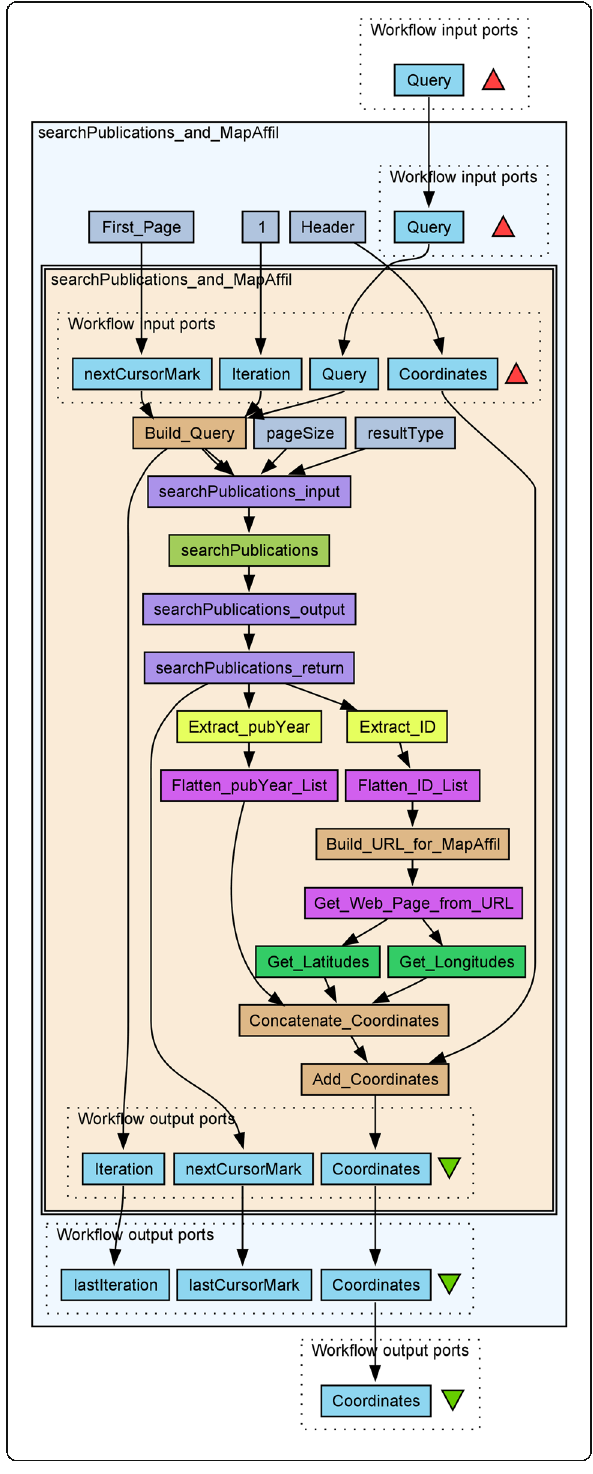
Fig. 2 The searchPublications_and_MapAffil workflow . The Taverna workflow searchPublications_and_MapAffil combining the Europe PMC searchPublications web service with the MapAffil geoparser to map publications in Europe PMC on a given topic. The innermost workflow is embedded for the looping construct in Taverna in order to retrieve all searchPublication results pages, pageSize = 100 records as a time for MapAffil. The cursorMarks were introduced in version 4.5.3 of the web services to robustly handle multiple results pages. Older workflows with offsets [13] no longer work with these services. The workflow is available on myExperiment